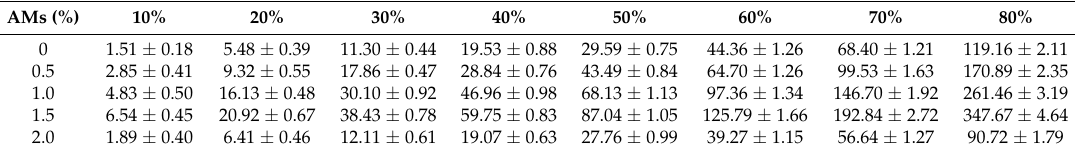
Table 3. The mean energy absorption values of investigated PUF foams at different strains (kJ/m 3 ).